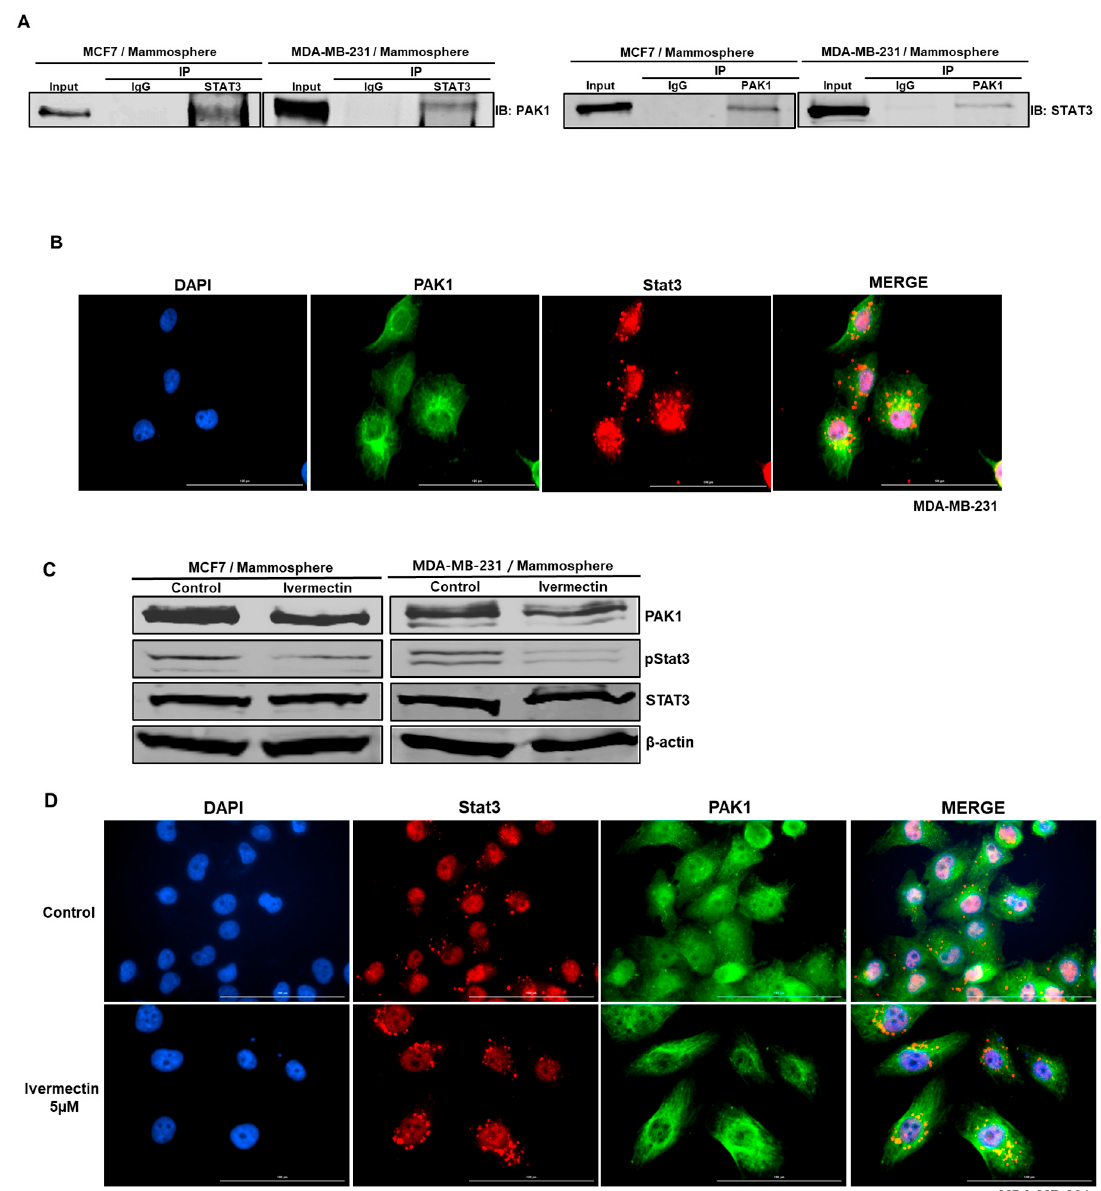
Figure 5. PAK1 physically interacts with Stat3, PAK1 and Stat3 colocalize in the nucleus and PAK1 inactivation induces Stat3 dephosphorylation. ( A ) Total protein from breast cancer cells was immunoprecipitated with anti-PAK1 or anti-Stat3 antibodies, followed by immunoblotting using anti-Stat3 or anti-PAK1 antibodies. ( B ) Immunofluorescence analysis of PAK1 (green) and Stat3 (red) expression in breast cancer cells using the indicated antibodies. Images were captured by microscopy at 10 × magnification. ( C ) E ff ect of ivermectin on the pStat3 level. ( D ) Immunofluorescence analysis of PAK1 (green) and Stat3 (red) expression levels in breast cancer cells after ivermectin treatment. Images were captured by microscopy at 10 × magnification (scale bar = 100 µ